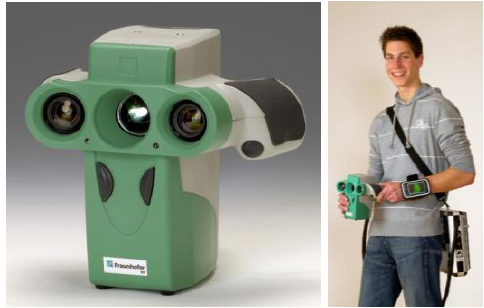
Figure 1. Handheld 3D sensor system “kolibri Cordless” (left),